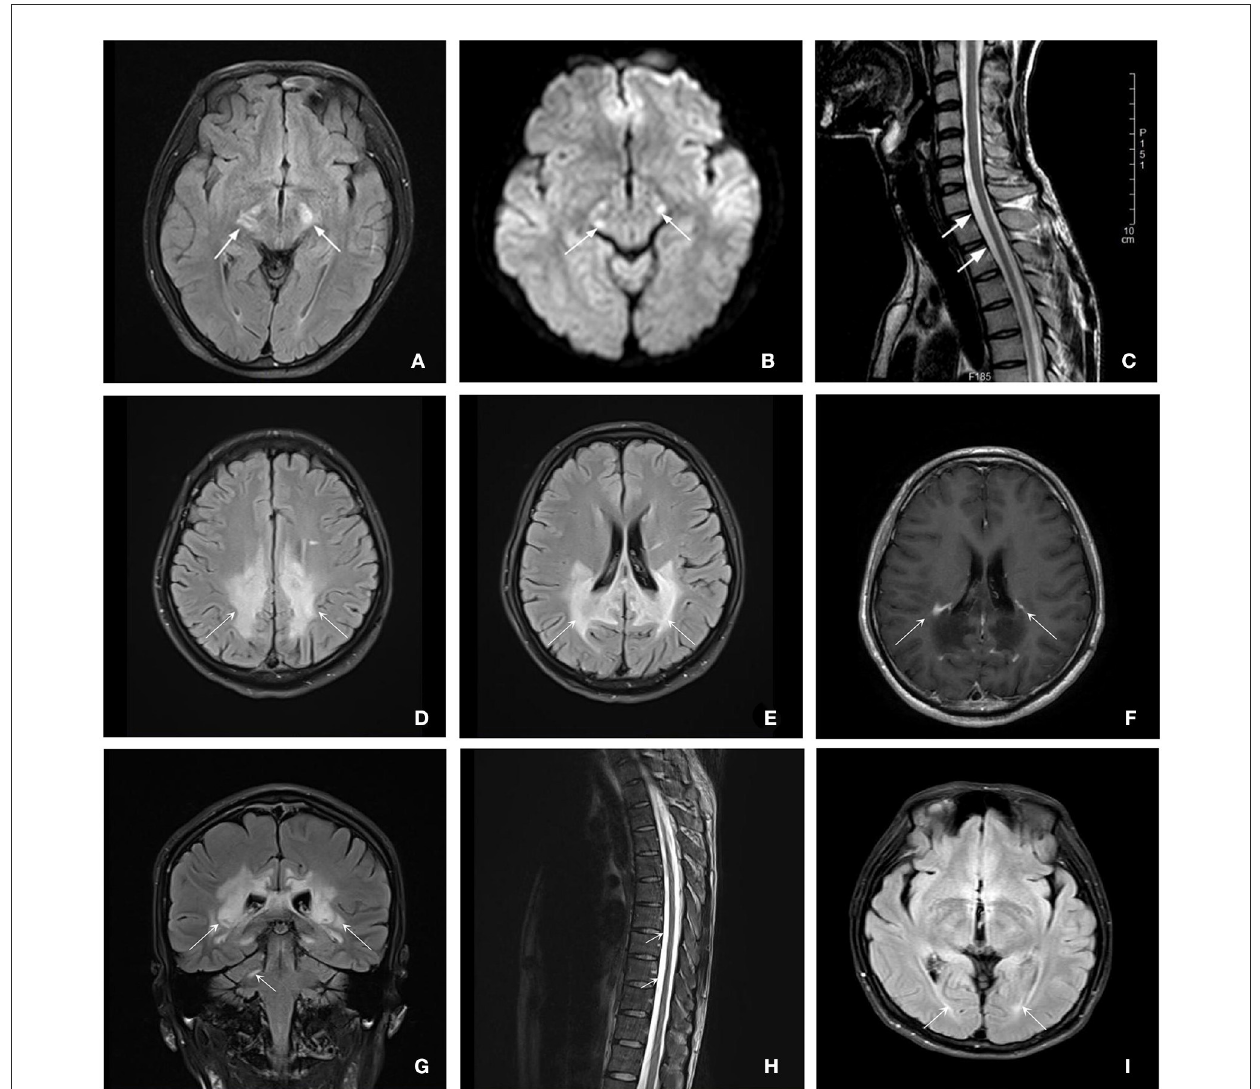
FIGURE2 Brain and spinal MRI for patients with ALD. Patient 1 (A–C) : (A, B) Axial T2-flair and DWI images of brain MRI showed a hyperintensity of bilateral cerebral peduncle (7 years after disease onset) (white arrows). (C) Sagittal T2-weighted image of spinal MRI showed the white arrows show lower cervical and upper thoracic spinal cord local atrophy detected (6 years after disease onset) (white arrows). Patient 2 (D–H) : (D, E) Axial T2-flair images showed extensive hyperintensity involving the frontal and parietal white matter and corpus callosum (white arrows). (F) Axial enhanced T1-weighted MRI showed partial linear enhancement at the lesion edge (white arrows). (G) Coronal T2-flair images showed extensive hyperintensity involving the periventricular white matter and the right dentate nucleus of the cerebellar (white arrows). (H) Sagittal T2-weighted image of spinal MRI indicated the thoracic spinal cord local atrophy detected (white arrows). Patient 3 (i): (I) Axial T2-flair and DWI images of brain MRI showed a slight hyperintensity of the periventricular white matter next to posterior horns (3 years after disease onset) (white